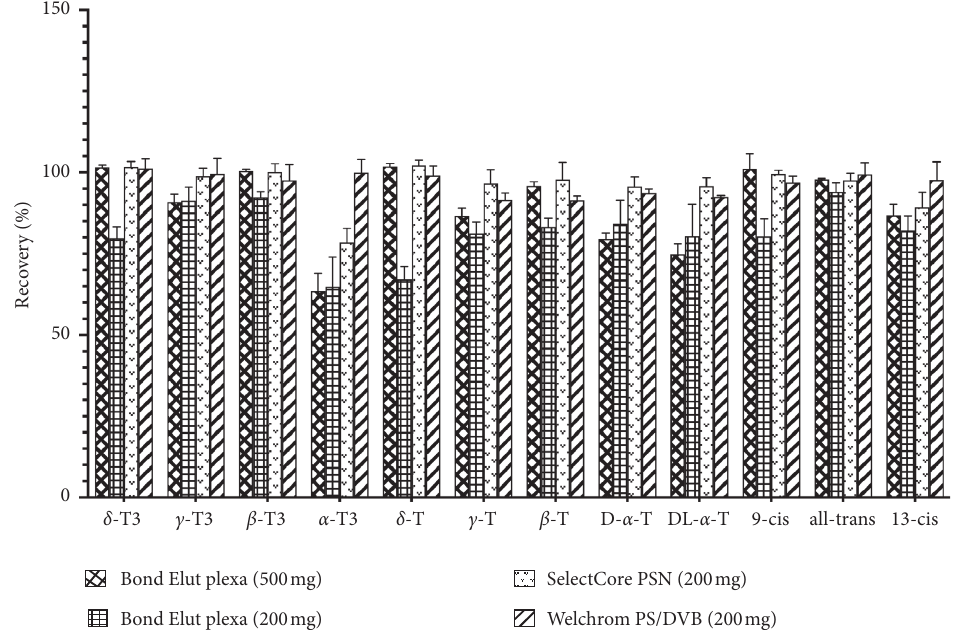
Figure 2: Appearances of different brand SPE columns on retinols, tocopherols, and tocotrienols (T: tocopherol; T3: tocotrienol; 9-cis: 9-cis- retinol; 13-cis: 13-cis-retinol; all-trans: